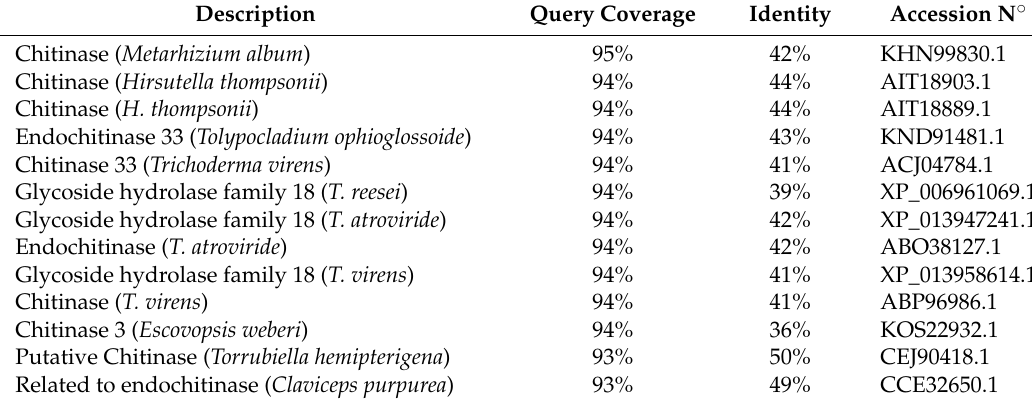
Table 1. Comparison of the partial chitinase sequence of L. muscarium CCFEE 5003 with other fungal chitinase as obtained by NCBI GenBank database query with BlastX. Only some of the best matches are shown.